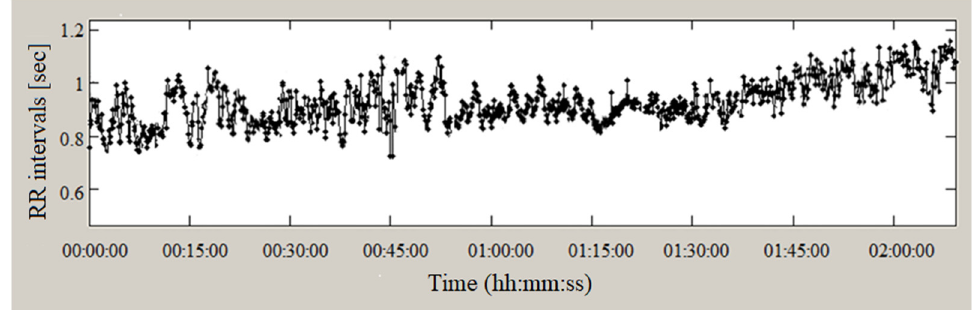
Figure 14. PP intervals (PPG signal, heart failure). Table 7. HRV parameters for ECG, Holter, and PPG records.